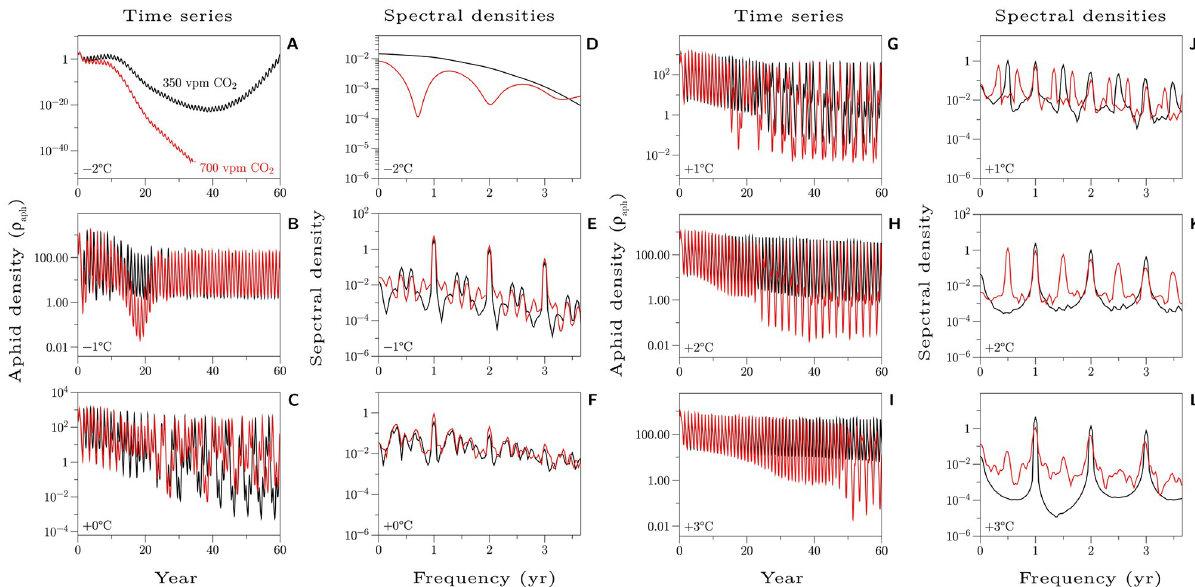
Fig 4. Aphid density dynamics. Shown are the time series of aphid densities ( ρ aph ) for incremental increases in temperature from − 2˚C to + 3˚C. 350 vpm